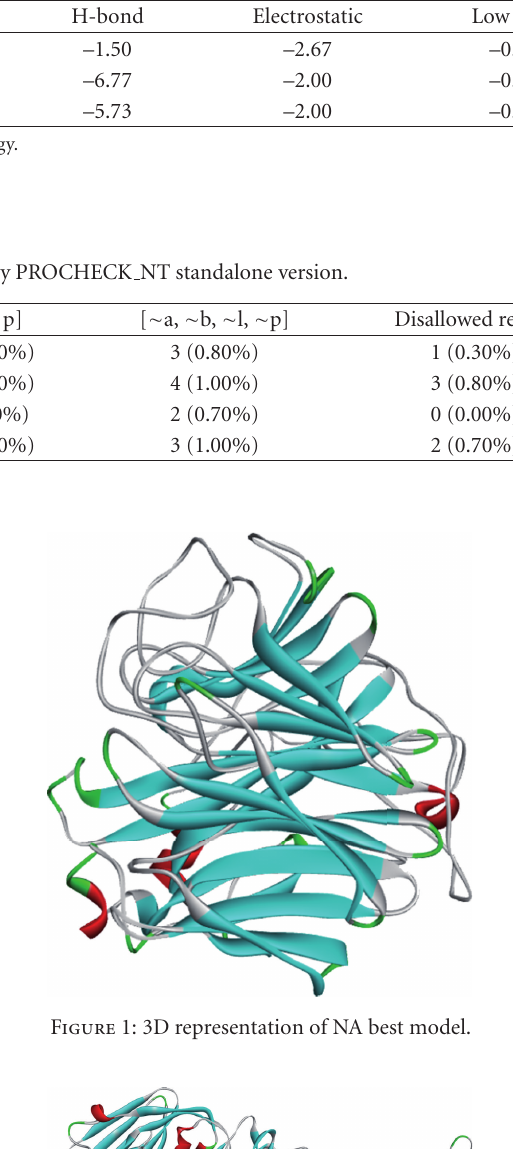
Table 1: Docking of Oseltamivir, Beta-Sialic acid, and O-Sialic acid from XP method. Sl. no.